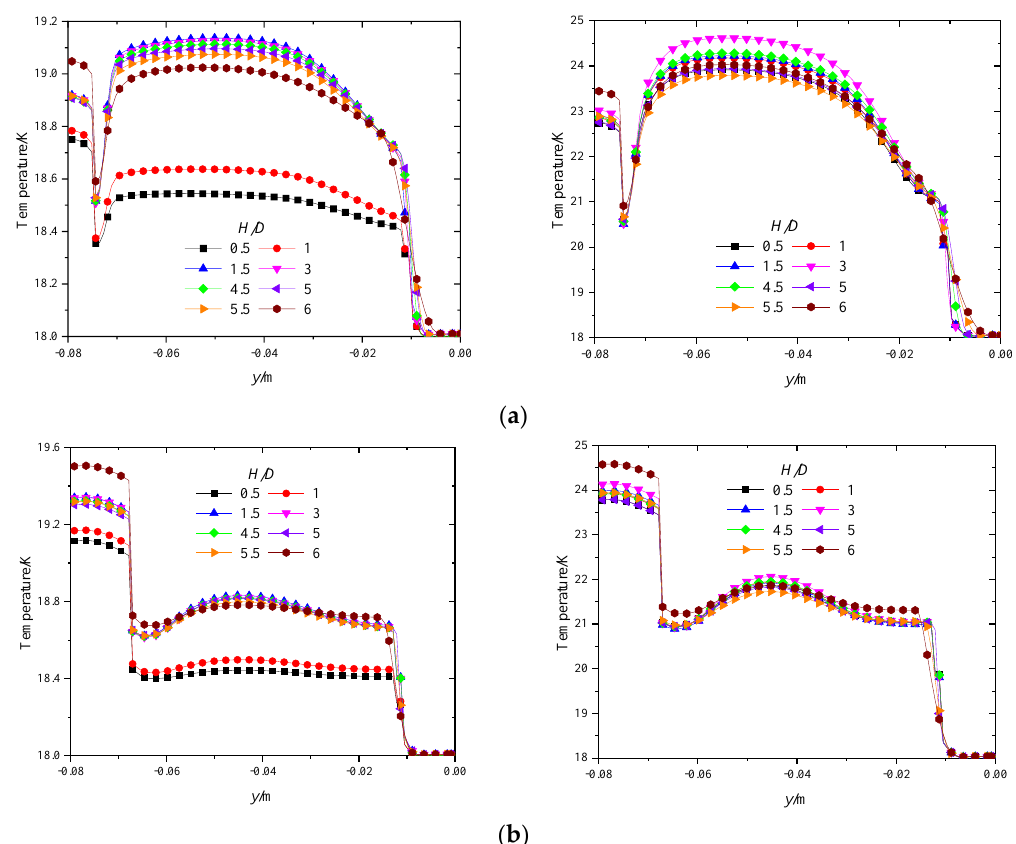
Figure 17. The variation of the temperature with y at specific x section (Left:100 kW; Right:500 kW): ( a ) x = 0 mm; ( b ) x = −45 mm.